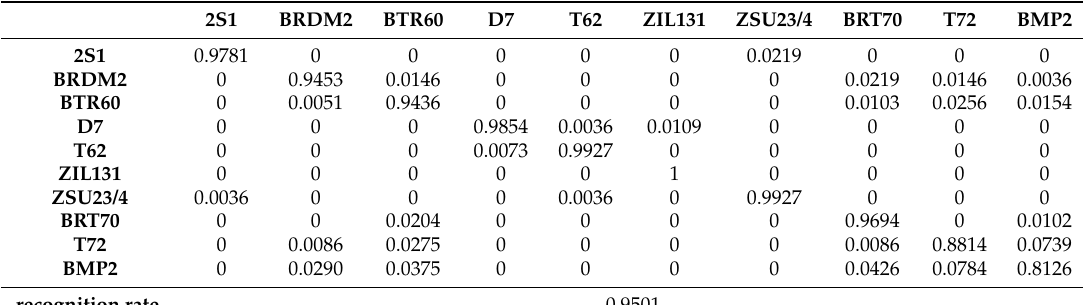
Table 16. The result of label consistent K(LCK)-SVD based on SAR-HOG under SOC.